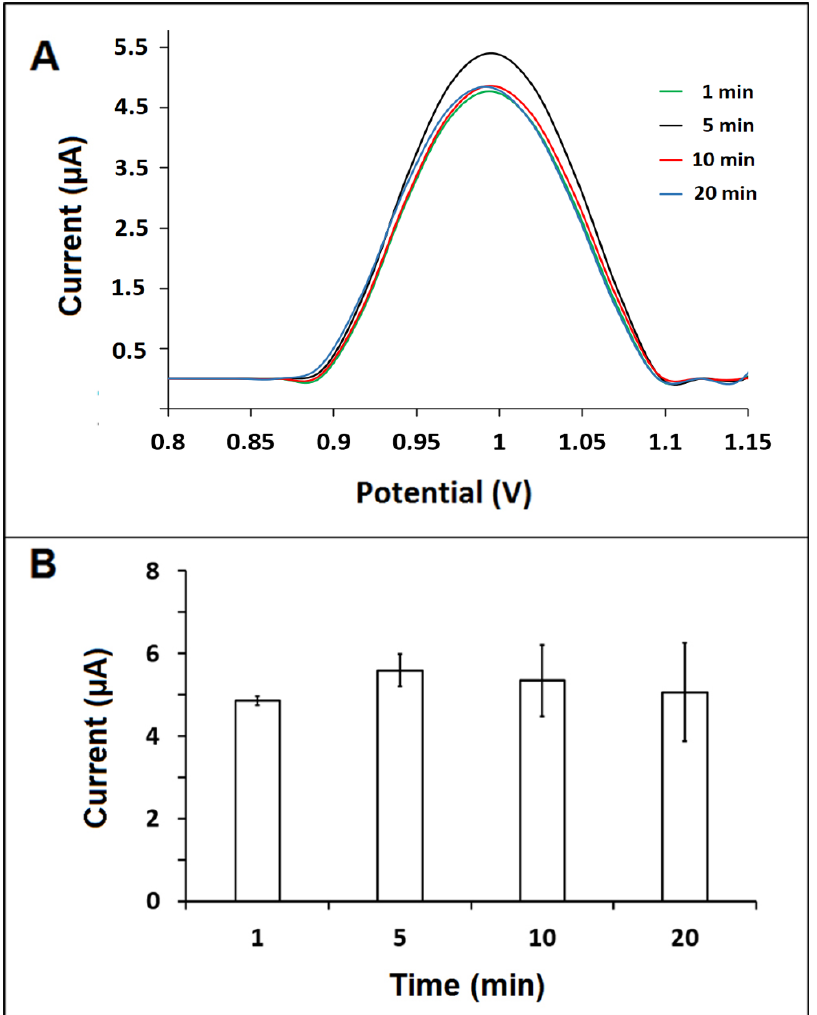
Figure 8. ( A ) DPVs. ( B ) The average guanine oxidation signals recorded by GO-IL-PGEs after hybridization of the 6 µg/mL BRCA1 probe with the 10 µg/mL BRCA1 target for 1, 5, 10, and 20 min ( n = 3).